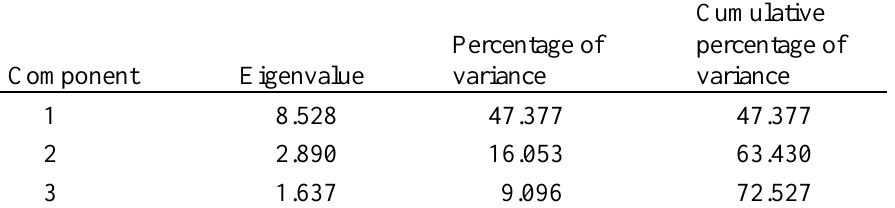
Table 2 Eigenvalues, Percentage of Explained Variance and Cumulative Percentage of Explained Variance